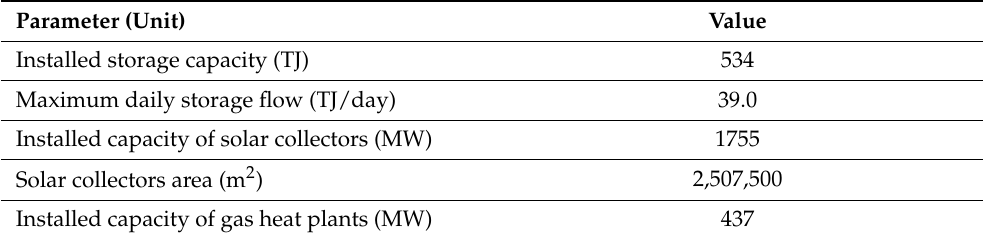
Table 12. The quantities characterizing the modelled system with the participation of heat from solar collectors =